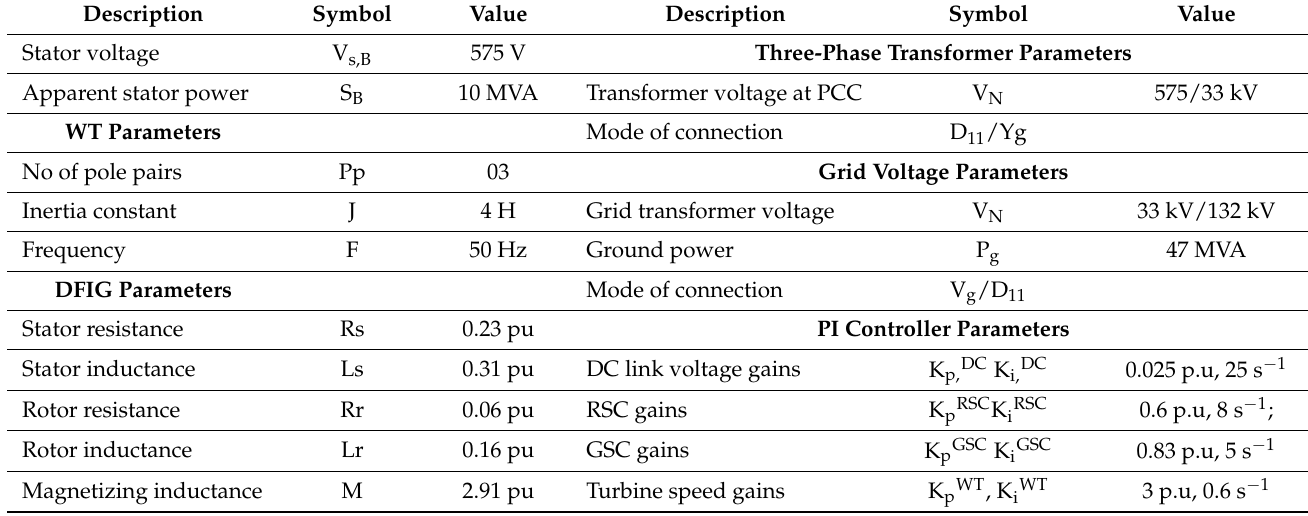
Table 1. Simulation parameters of grid-integrated DFIG.